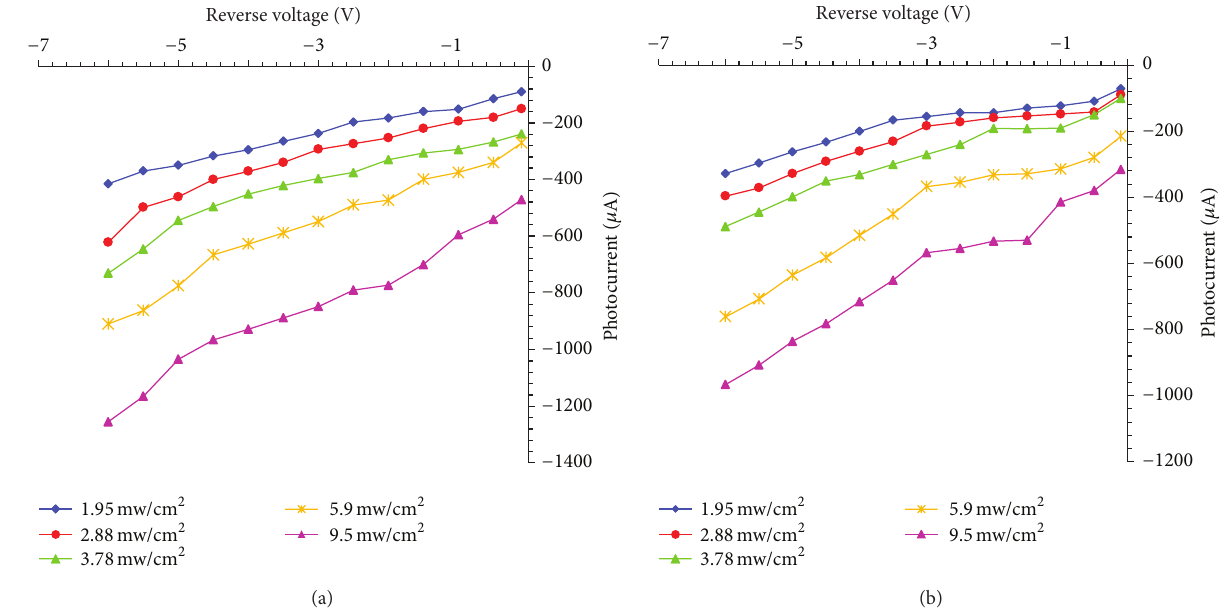
Figure 5: Photo-urrent as a function reveres voltage. (a) (n-SnO 2 /SiO 2 /n-Si) MIS device, (b) (n-SnO 2 /SiO 2 /p-Si) MIS device.